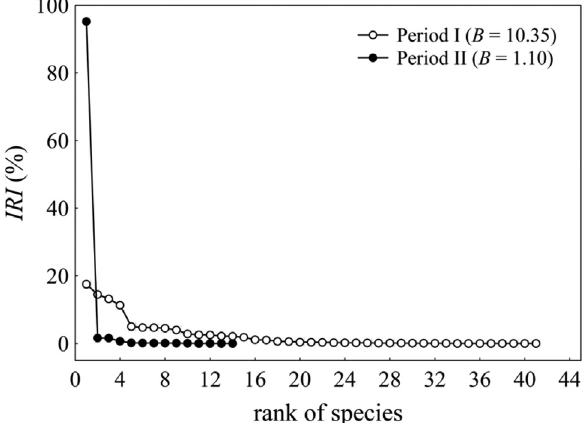
Fig. 3. Dominance curve of prey items in the diet of Acestro- rhynchus pantaneiro , based on Index of Relative Importance (IRI) in each sampling period at Manso Reservoir, Mato Grosso State, Brazil (n = 314; 187-period I and 127- period II). B = trophic niche breadth.